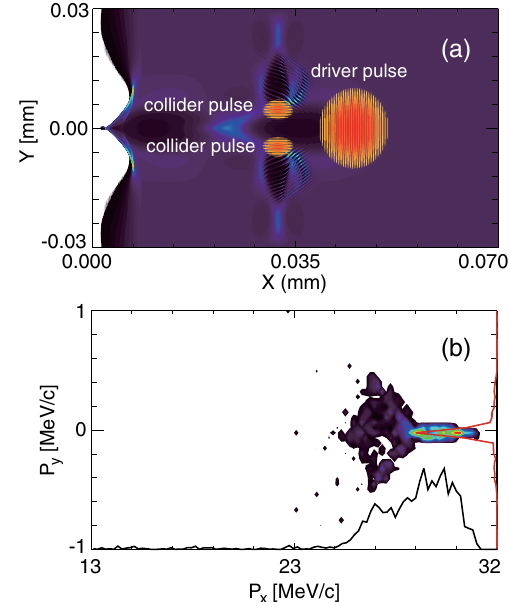
FIG. 1. (a) Plasma density and laser intensity distribution at t ¼ 200 fs. (b) Phase space distribution ( P preionized and laser-ionized electrons after the drive pulse propagated 0.79 mm. The right red curve shows the transverse momentum spread after longitudinal integration. The lower black curve shows the beam energy